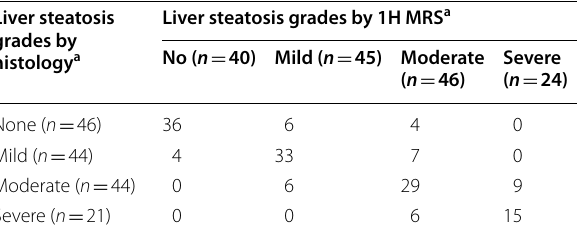
Table 3 Comparison between hepatic steatosis staging by histology and 1H